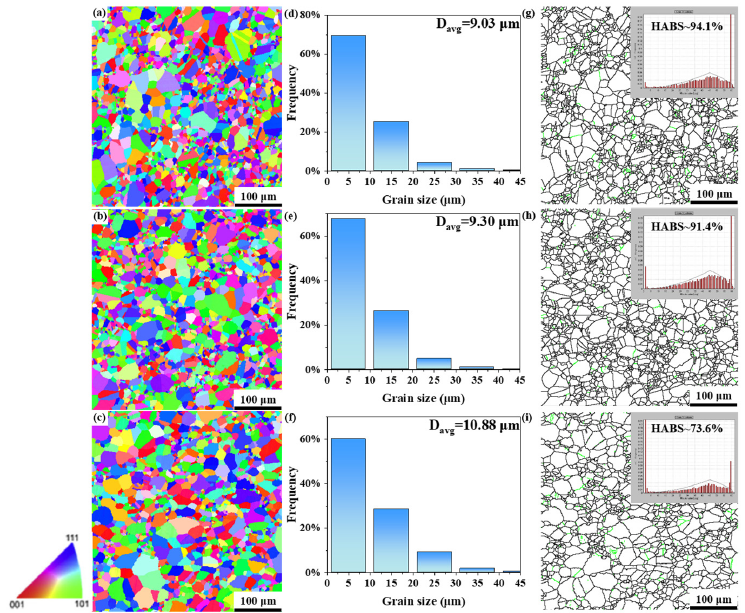
Figure 11. Inverse pole figure and Frequency histogram of grain together with distribution of grain boundary misorientation in heat-treated Sc-doped U720Li: ( a , d , g ) 0 wt.% Sc, ( b , e , h ) 0.043 wt.% Sc, ( c , f , i ) 0.066 wt.% Sc. Green lines represent the low angle boundaries (LABs) (0–15°) but the high angle boundaries (HABs) (>15°) were indicated by black lines.